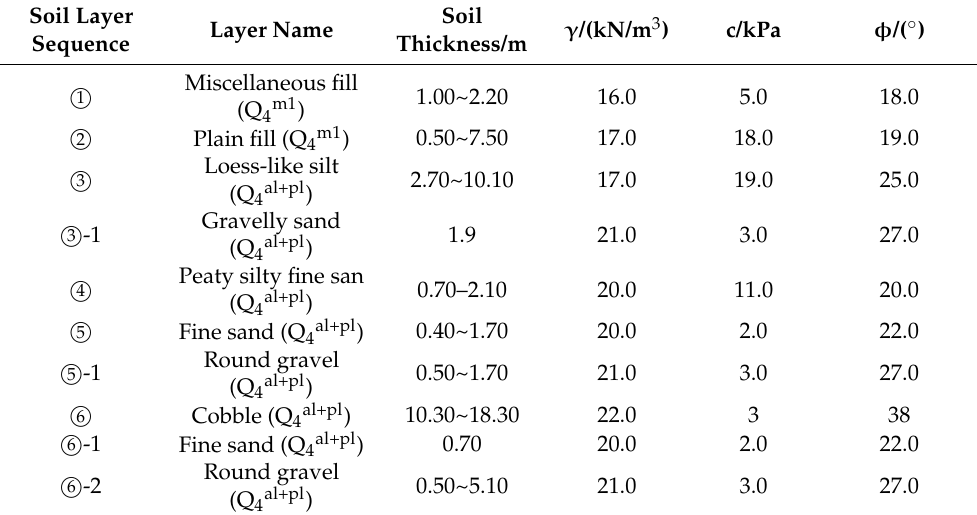
Table 1. Basic parameters of each rock and soil